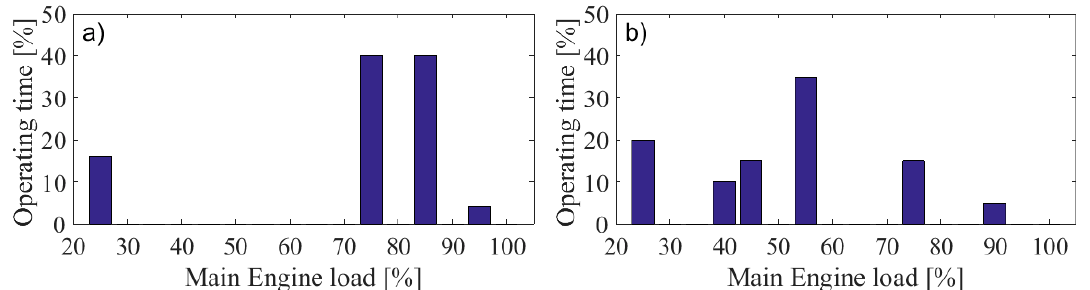
Figure 4. Considered annual engine load profiles: ( a ) Feeder, ( b ) Container vessel. Table 3. Characteristics of the exhaust gases of the two engines as a function of the engine load [36].